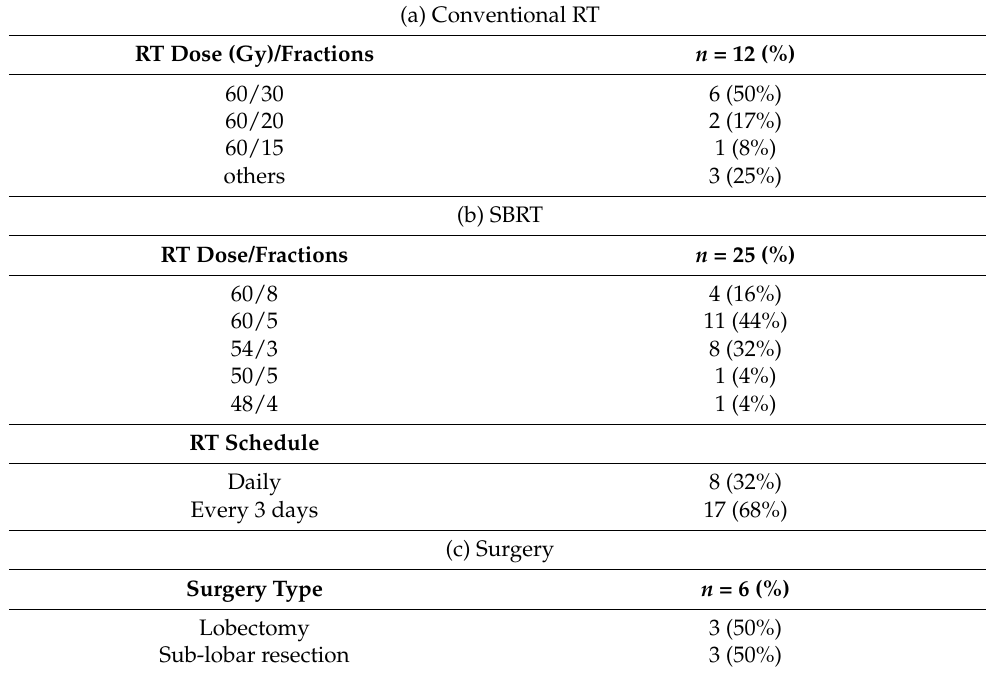
Table 2. Curative-intent treatment